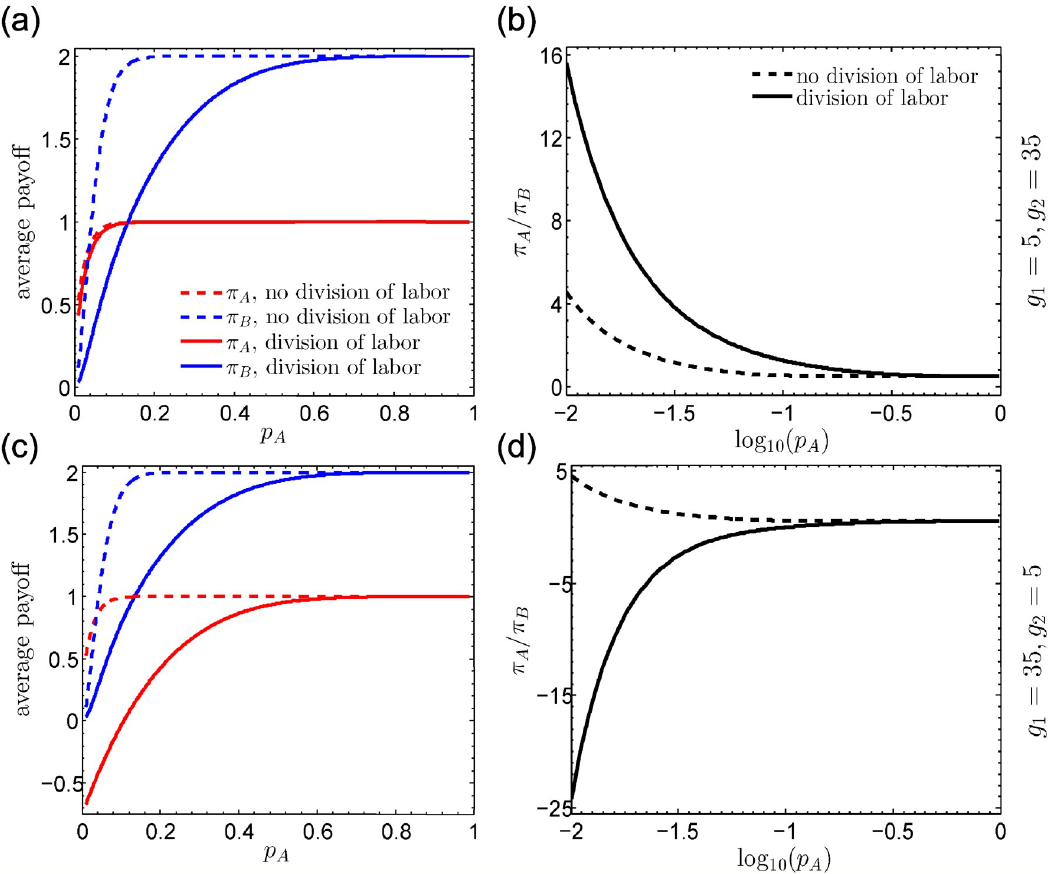
Fig 5. Average payoffs as a function of p A with no division of labor (dash lines) and with division of labor (solid lines). Here the increasing number of cooperators does not lead to increasing productivity, inasmuch as the number exceeds the threshold. (a) For g 1 = 5 and g 2 = 35, division of labor does not affect the average payoff of A-players ( π A ) much while it reduces the average payoff of B- players ( π B ) significantly. This increases π A / π B for the whole range of p A (b), and thus weakens the advantages of defectors over cooperators. (c) For